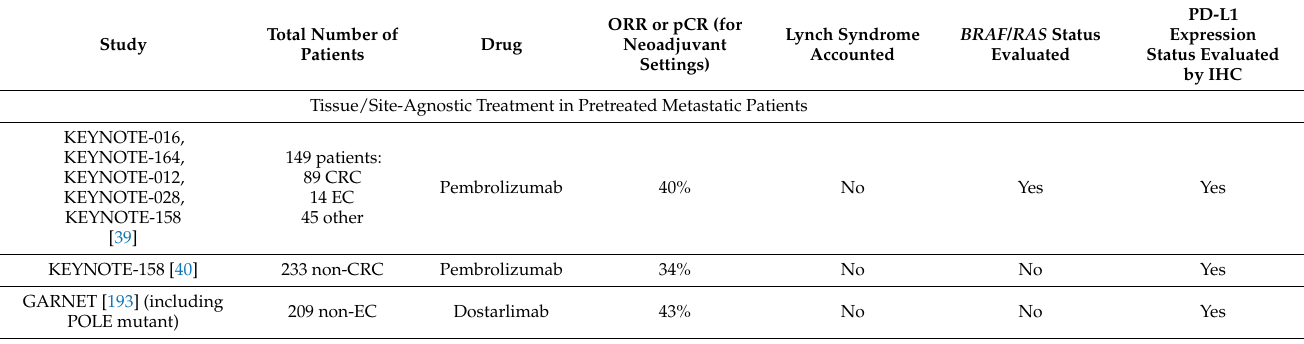
Table 2. Response rates of MSI/dMMR tumors to ICI therapy in selected clinical